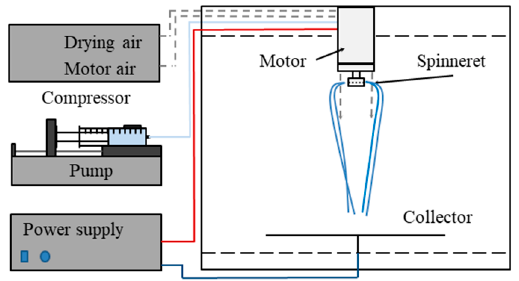
Figure 1. Schematic representation of high-speed electrospinning.